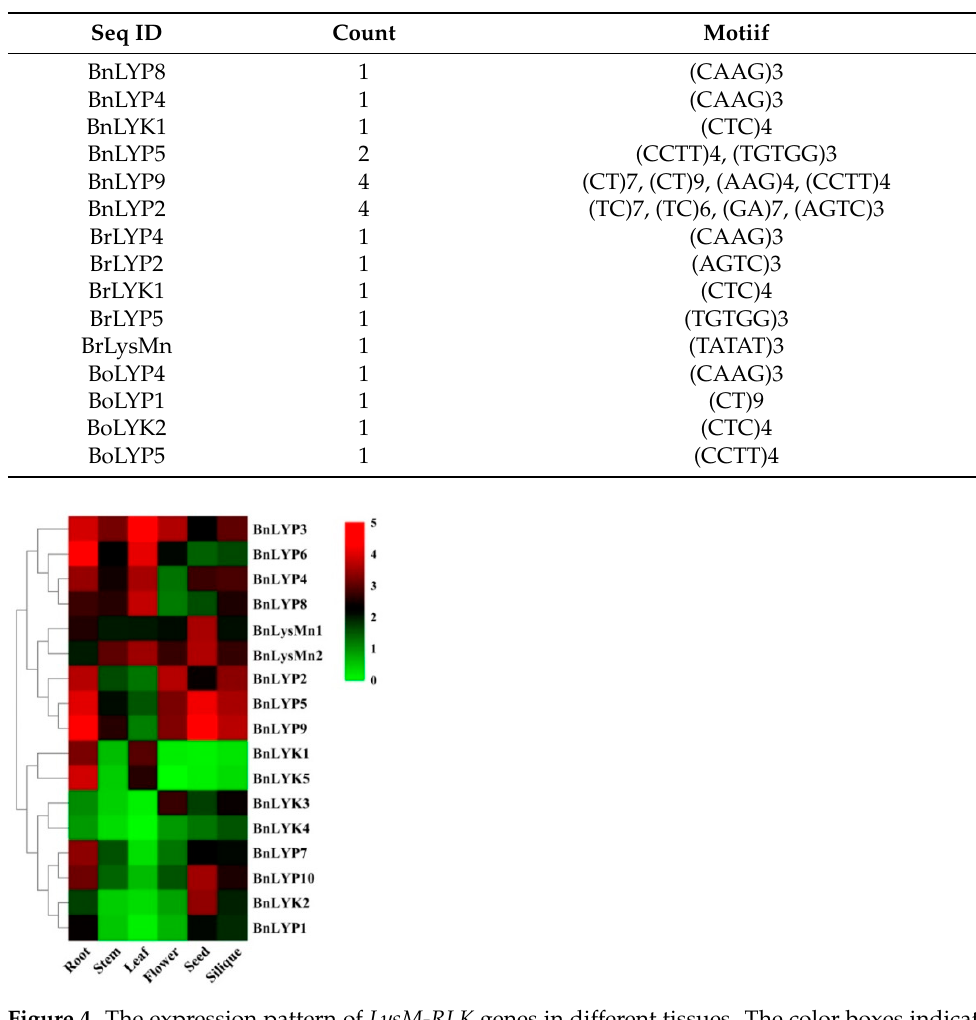
Table 2. Simple sequence repeats (SSR) were detected in Brassica LysM-RLK genes.